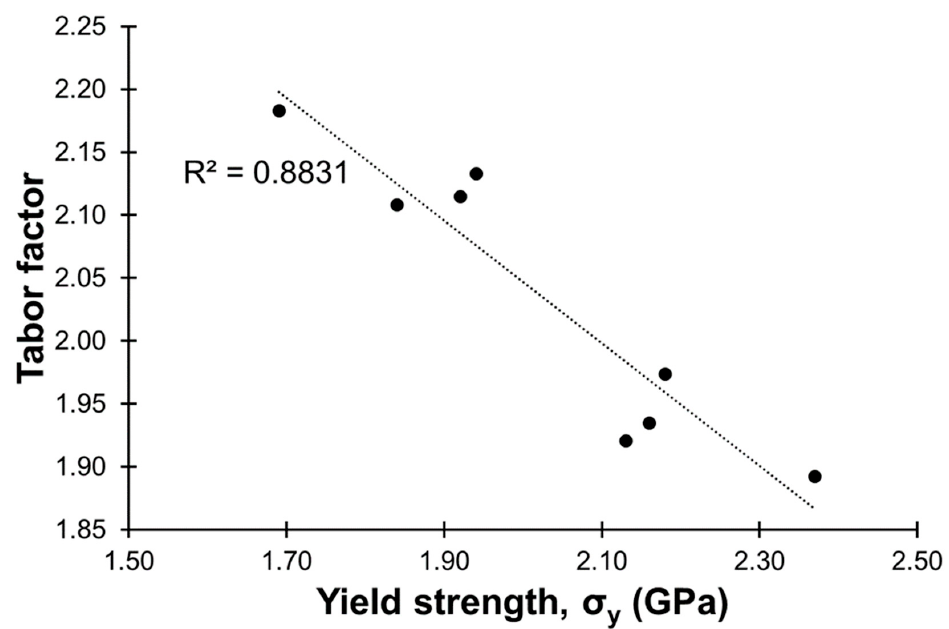
Figure 9. Relationship between the yield strength and the Tabor factor.